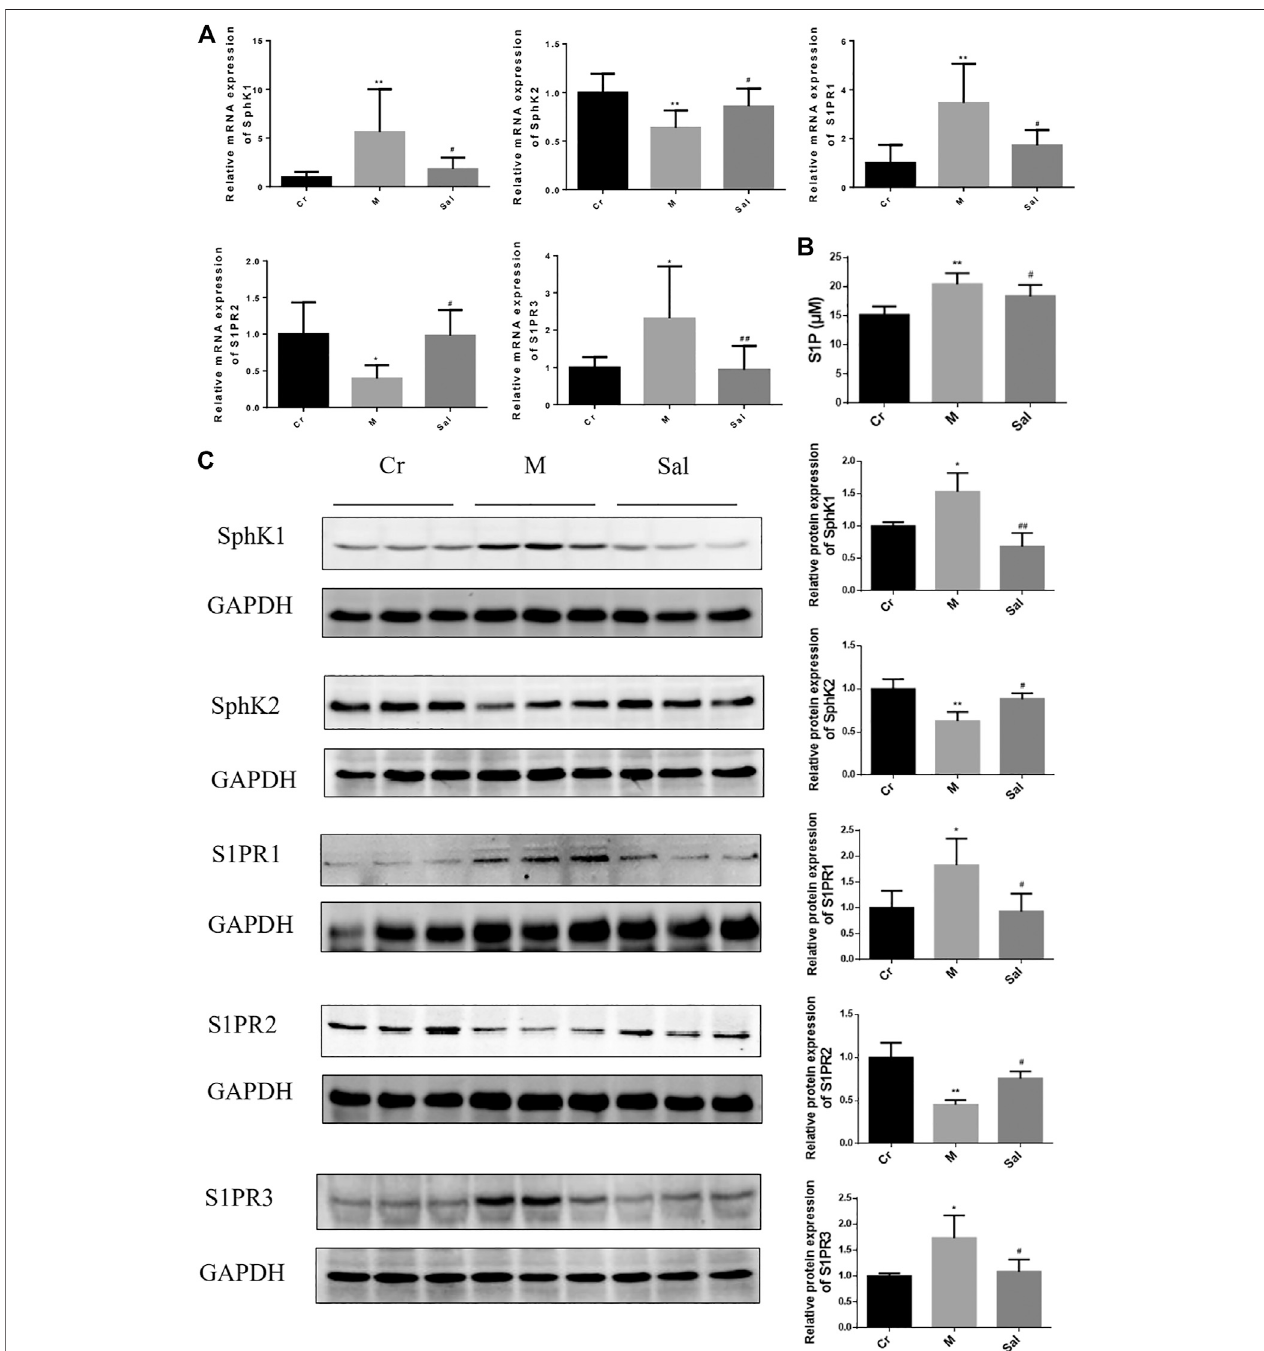
FIGURE3| EffectsofSal ontheexpressions ofSphK/S1P/S1PRssignalingpathway inmice liverinducedbyCCl 4 . (A) :ThemRNAexpressionsofSphK1, SphK2, SPPR1, S1PR2 and S1PR3 in mice liver tissue. (B) : Level of S1P in serum from mice. (C) : The protein expressions of SphK1, SphK2, of S1PR1, S1PR2, and S1PR3 in micelivertissue( n (cid:1) 15,* p < 0.05,** p < 0.01,vsCr; # p < 0.05, ## p < 0.01,vs.M.)SphK1:Sphingosinekinase1;S1P:Sphingosine-1-phosphate;S1PR1:Sphingosine1- phosphate receptor 1; S1PR2: Sphingosine 1-phosphate receptor 2; S1PR3: Sphingosine 1-phosphate receptor 3.